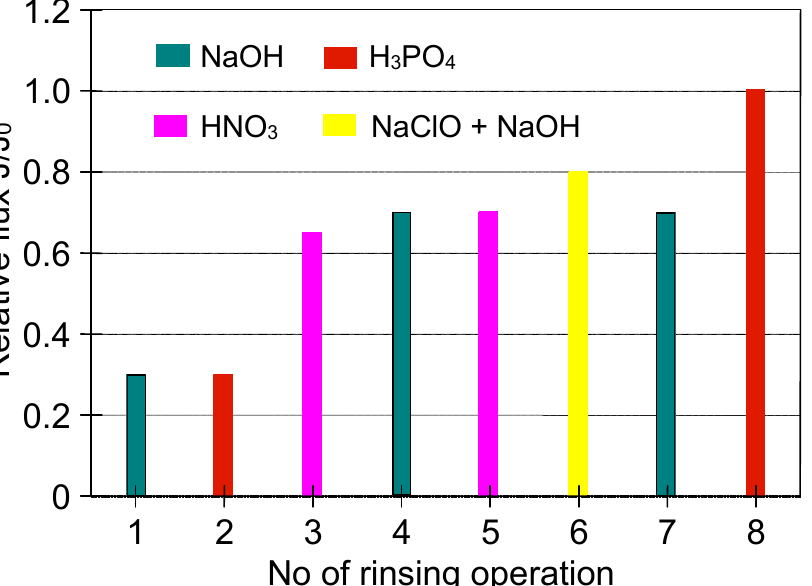
Figure 24. The efficiency of cleaning the ceramic membrane after the MF of yeast suspension (the